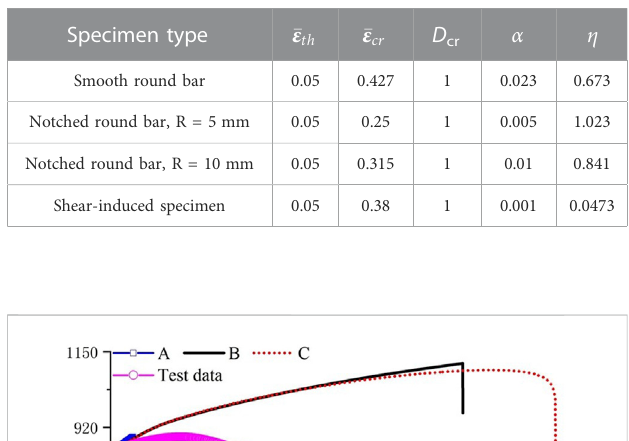
TABLE 3 The parameters for Bonora damage model.